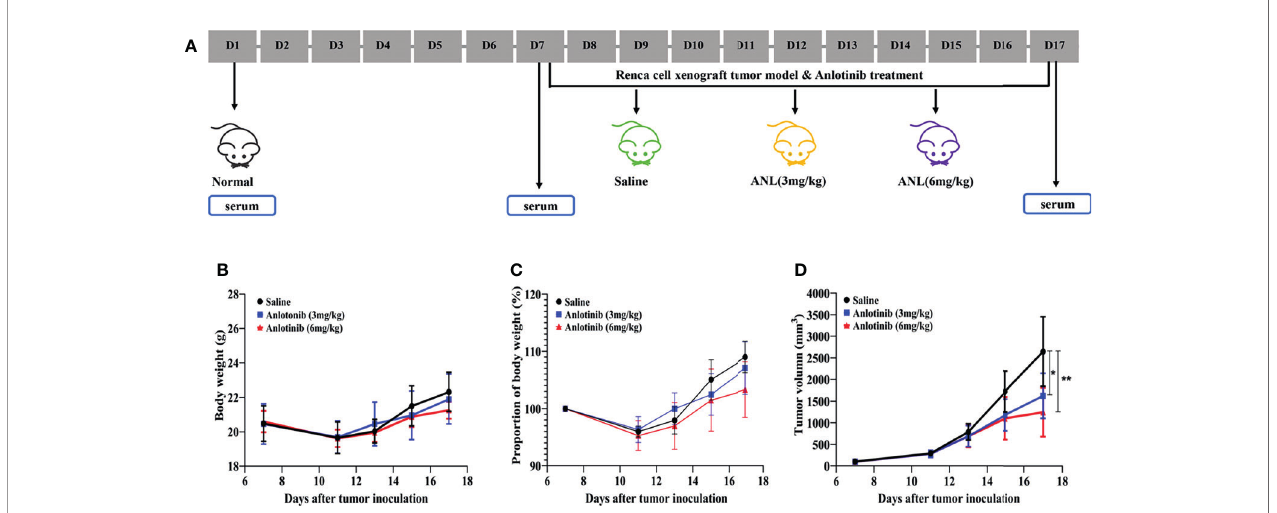
FIGURE 1 | In vivo antitumor activities of anlotinib in a Renca cell syngeneic model in mice. (A) The timeline of the animal experiment. (B) Bodyweight. (C) Bodyweight variance. (D) Relative tumor volume at indicated time points ( n =5). Data are shown as means ± SEM. *p < 0.05, **p < 0.01 vs